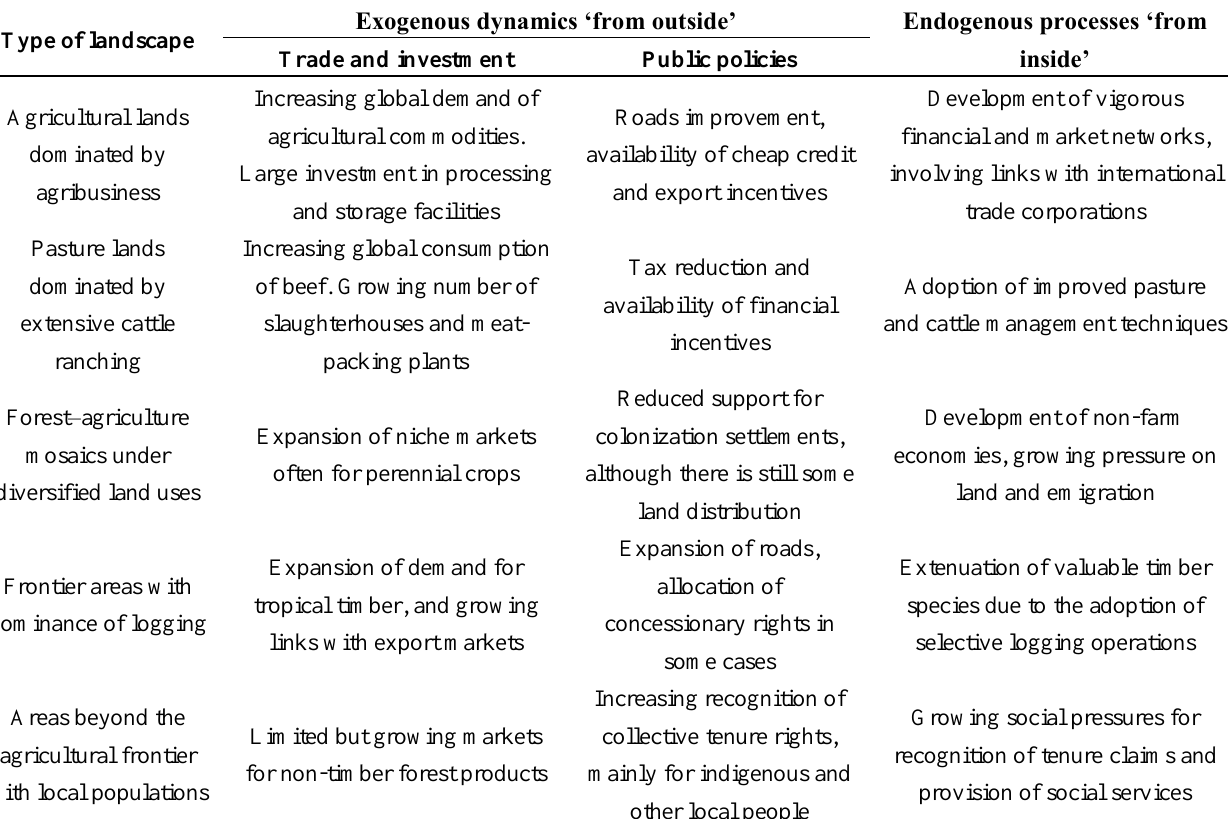
Table 3. Factors shaping landscape transformation in tropical Latin